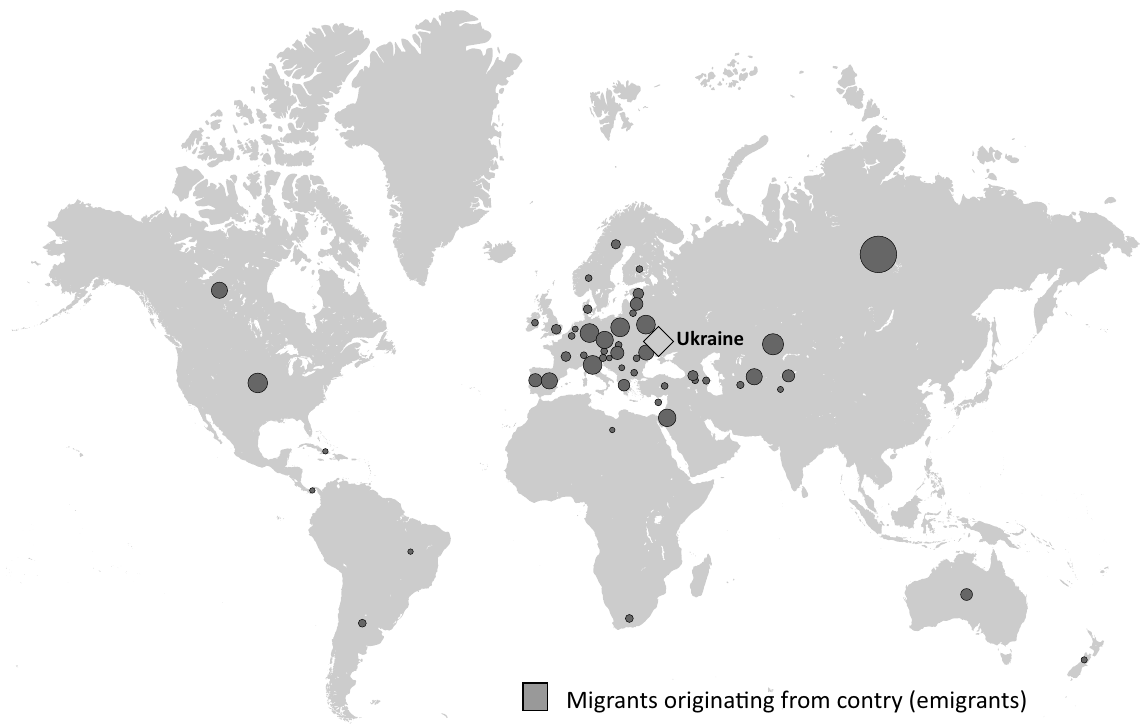
Migrants origina�ng �rom contry